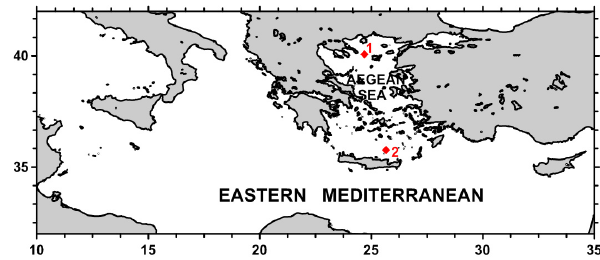
Figure 1. Location of the two sites in the North (1) and South (2) Aegean Sea at which the surface heat exchanges are correlated with the field of